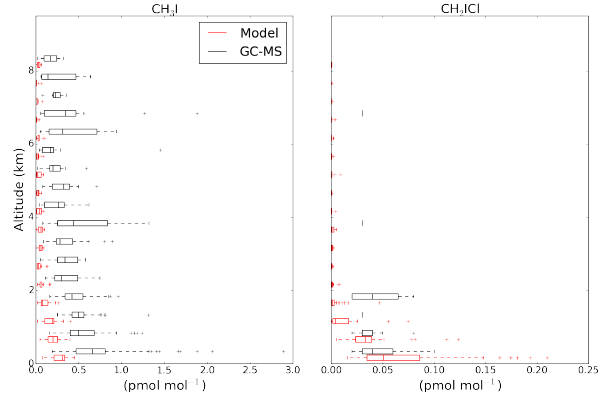
Figure 4. Vertical comparison of observations from the CAST (Combined Airborne Studies in the Tropics) campaign in the mid- Pacific (Guam). The observations are shown in black and simulated values with both iodine and bromine chemistry (“Br + I”) in red. Val- ues are considered in 0.5km bins, with observations and modelled values at the same location and time (as described in Sect. 2) shown side-by-side around the mid-point of each bin. The observations are from the FAAM BAE-146 research aircraft whole air samples analysed by Gas Chromatography–Mass Spectrometry (GC-MS). The box plot extents give the inter-quartile range, with the median shown within the box. The whiskers give the most extreme point within 1.5 times the inter-quartile